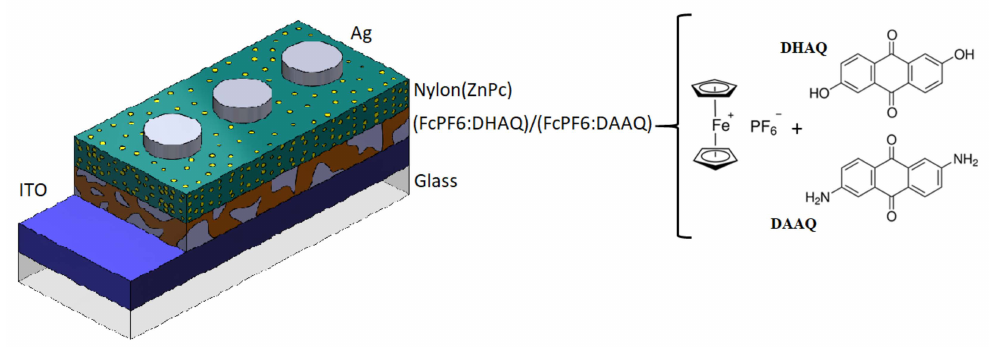
Figure 1. Scheme of the organic heterostructures with ITO and Ag